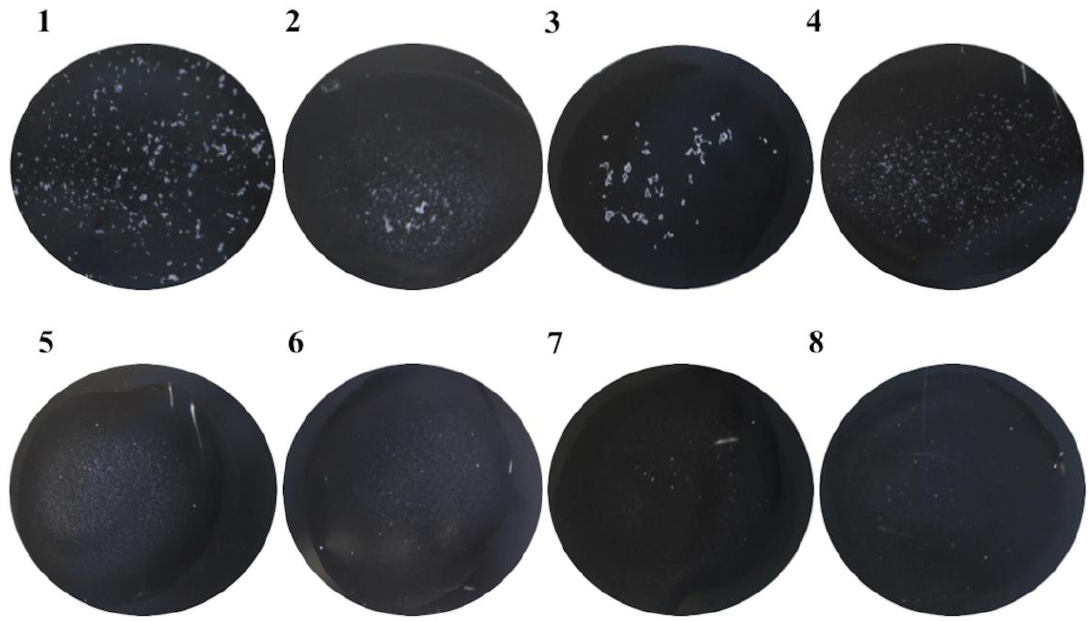
Figure 3. Representative example of the rapid latex agglutination test, with scFvStx1, against positive and negative isolates. The figure represents a 1-min reaction. ( 1 ) STEC O111:NM (human origin); ( 2 )